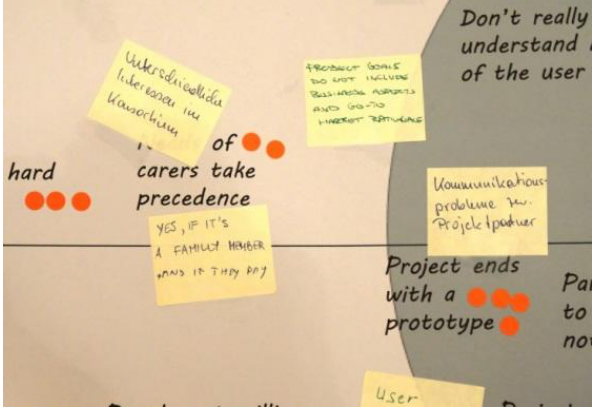
Figure 4. Excerpt from interactive poster. Yellow sticky notes were used to add new issues and red dots to support existing issues.